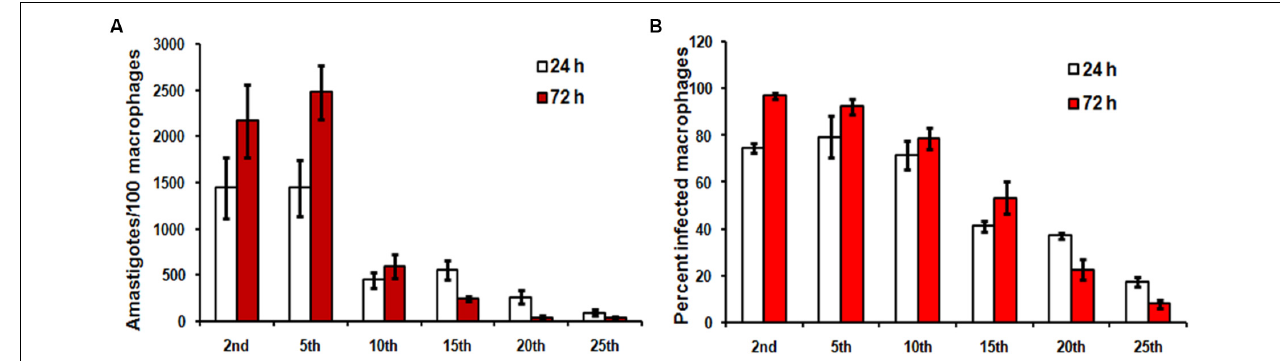
FIGURE 1 | In vitro hamster derived macrophage infection with different passages. Hamster macrophages were infected with stationary promastigotes of Leishmania donovani AG83, as described in Section “Materials and Methods” and the cells were incubated for 24 h and 72 h at 37 ◦ C, 5% CO 2 . (A) The number of amastigotes in each passage and (B) the percentage of infected cells were analyzed by counting 100 cells. Data shown are mean ± SE of experiment performed in quadruplet.